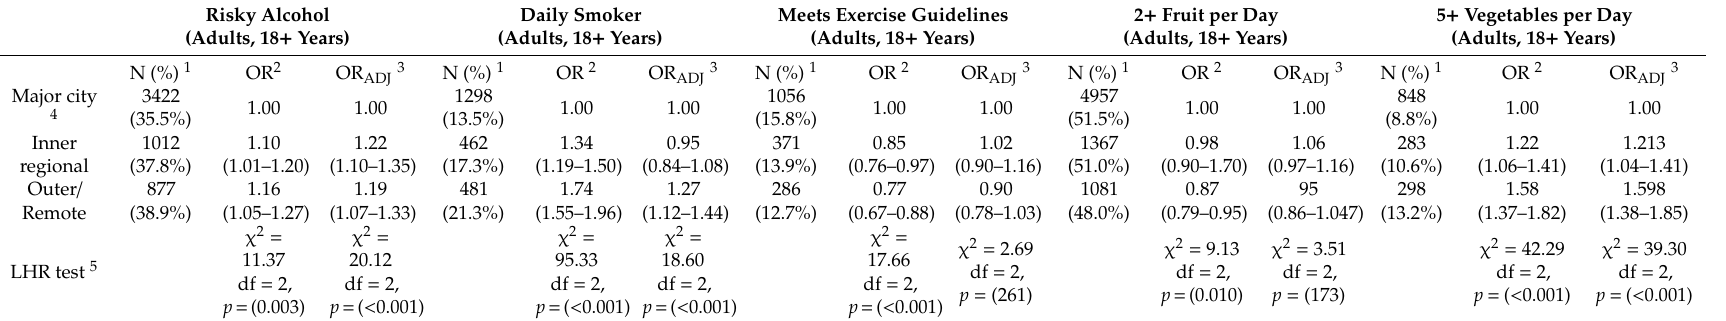
Table 3. Association between geographic remoteness and self-reported health behaviours ( N =